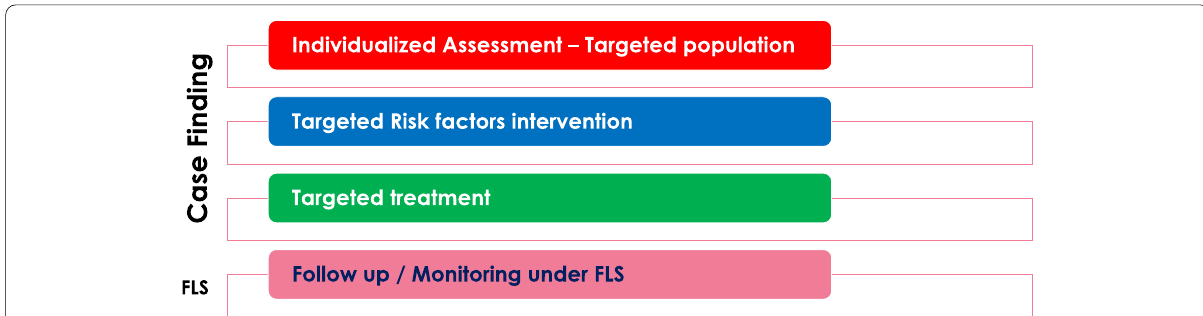
Fig. 1 Population screening approach for fracture risk assessment in postmenopausal women and older